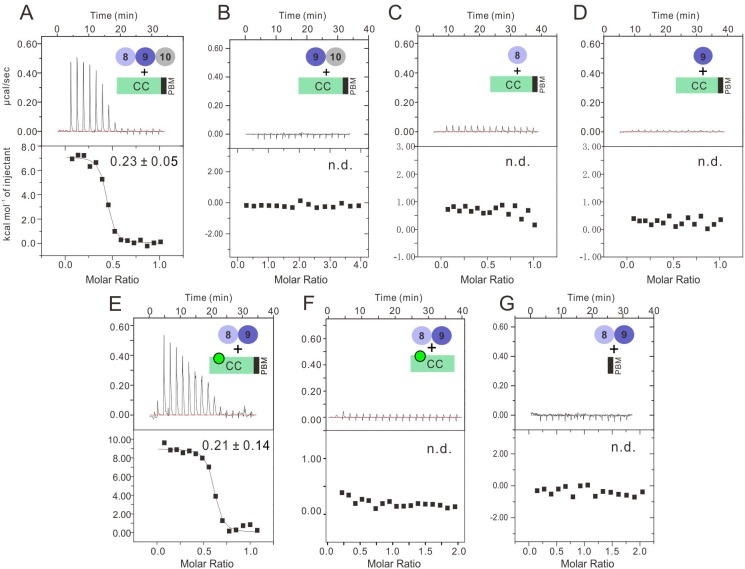
Characterization of the binding of INADL PDZ89 and the PLCβ4 CC-PBM.ITC-based measurement showing the binding affinities of INADL PDZ domains with PLCβ4 CC-PBM. (A) INADL PDZ8-10 and PLCβ4 CC-PBM. (B) INADL PDZ9-10 and PLCβ4 CC-PBM. (C) INADL PDZ8 and NORPA CC-PBM. (D) INADL PDZ9 and PLCβ4 CC-PBM. (E) INADL PDZ89 and PLCβ4 CC8KA-PBM mutant. (F) INADL PDZ8-9 and PLCβ4 CC8KA. (G) INADL PDZ8-9 and PLCβ4 PBM.